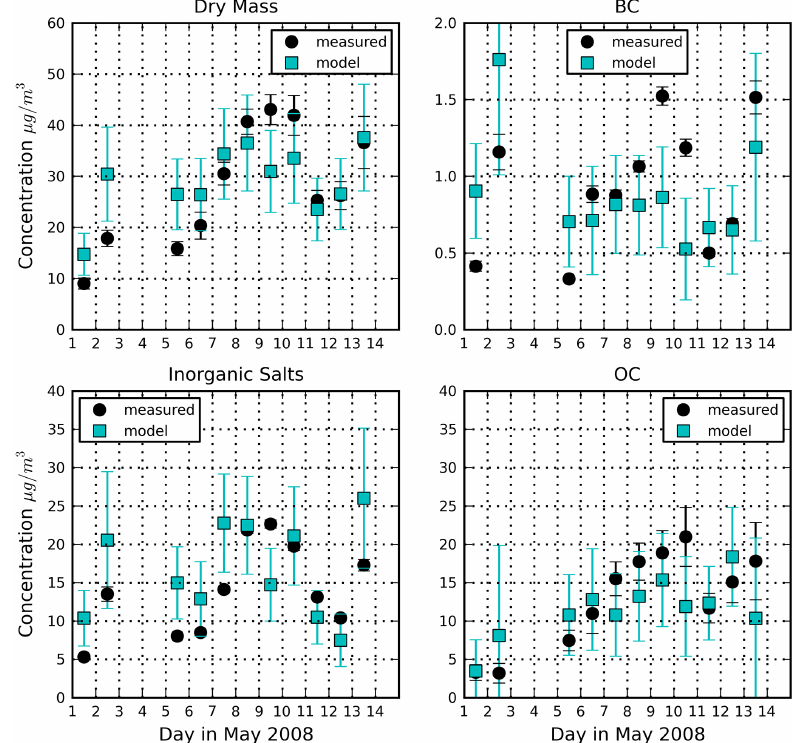
Figure 10. Modeled (turquoise squares) and observed (black dots) daily average concentrations of dry mass (PM 10 , upper left), black carbon (BC, upper right), inorganic salts (lower left) and organic matter (OC, lower right). Only the results of non-suspect AERONET data have been used in the averaging. The error bars show the uncertainty in modeled (turquoise) and observed (black) data.